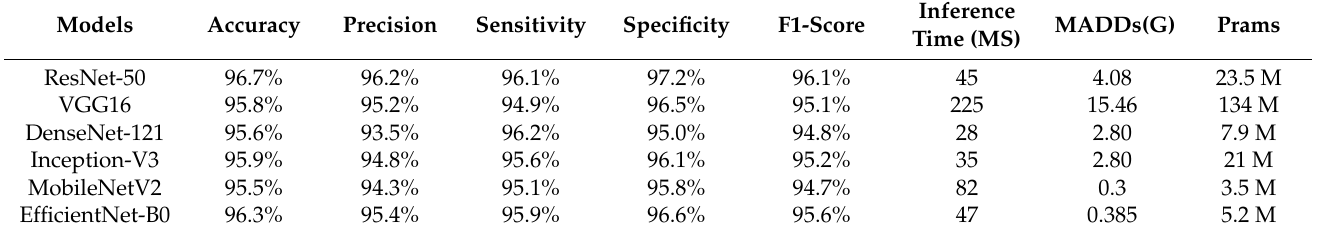
Table 4. Performance of classification models after applying the proposed method on COVID-19 X- rays.